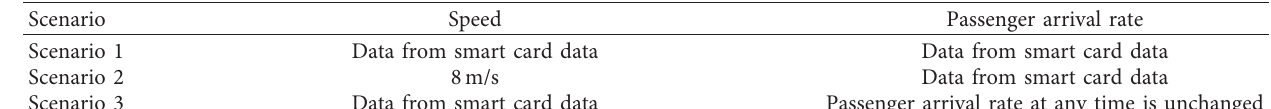
Table 6: Scenarios description.